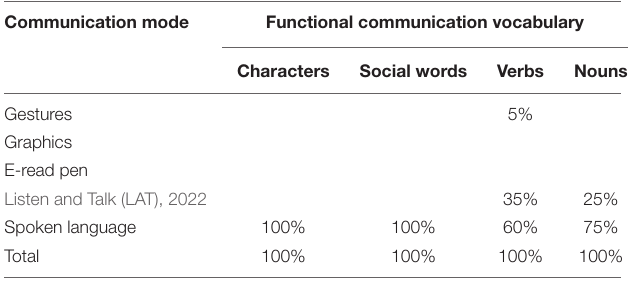
TABLE 4 | Communication mode following augmentative and alternative communication interventions.